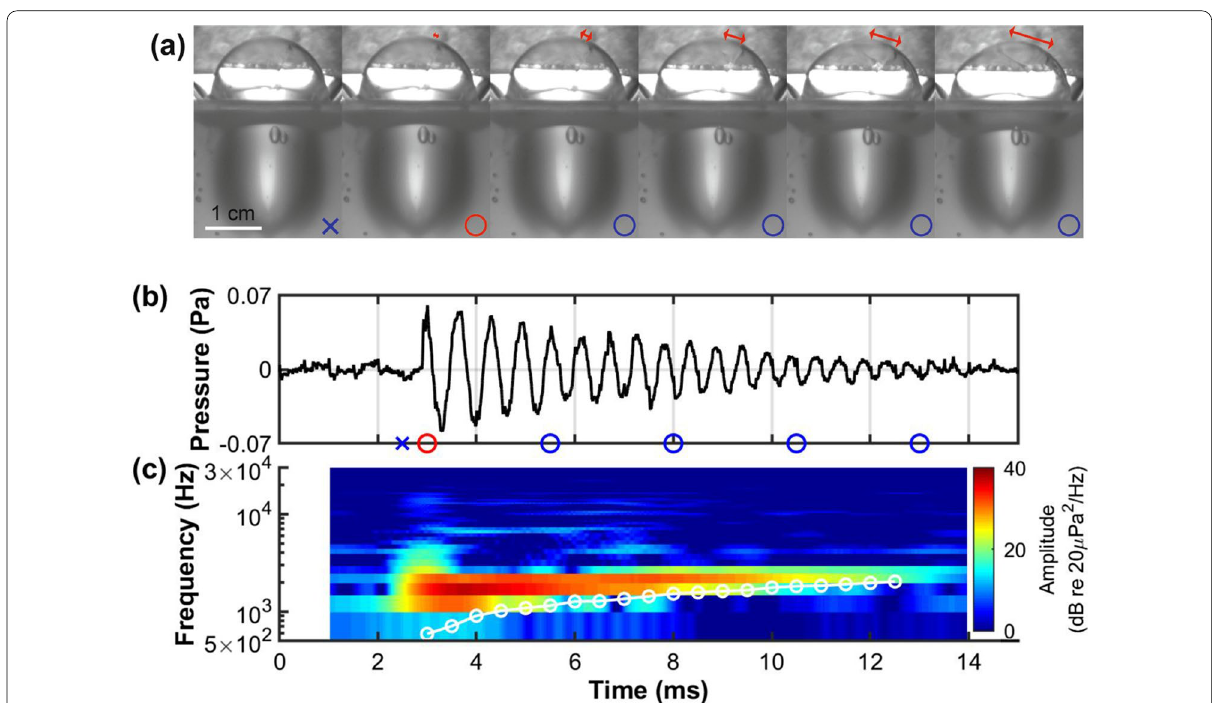
Fig. 7 An example of Helmholtz resonance (large bubble, case 5). V = 7 cm 3 bubble bursts while it is rising in a suspension of φ = 0.4 . a Time-lapse images (see Additional file 3: Movie 3). b Waveform (detrended, highpass filtered at 800 Hz). c Spectrogram of ( b ) using a 2.048 ms sliding window and 2.030 ms overlap. (cid:31) indicates the f H calculated from Eq. (11) using measured R